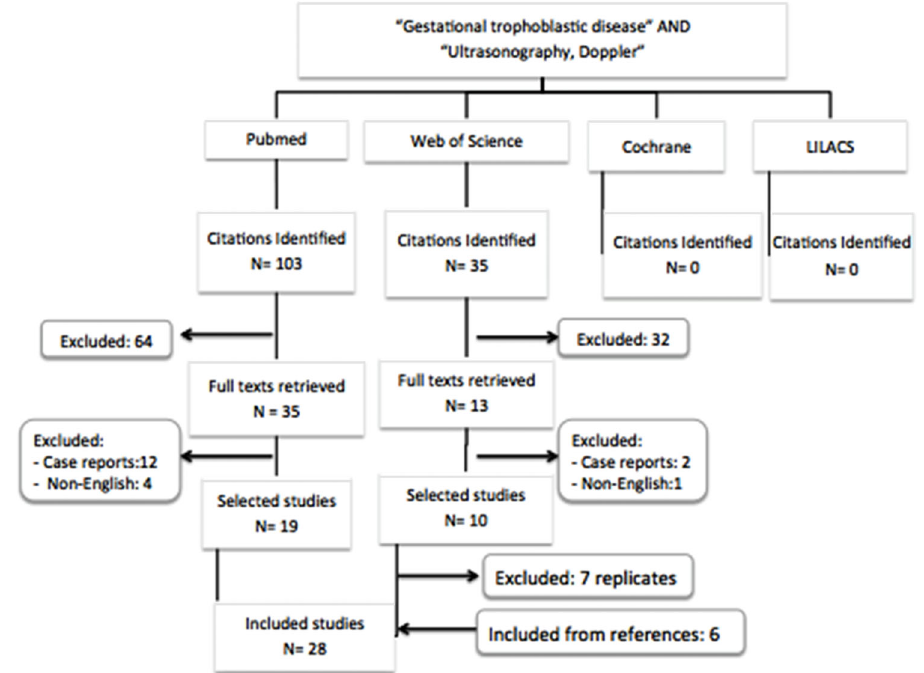
Figure 1 - Flow chart describing the mechanism of